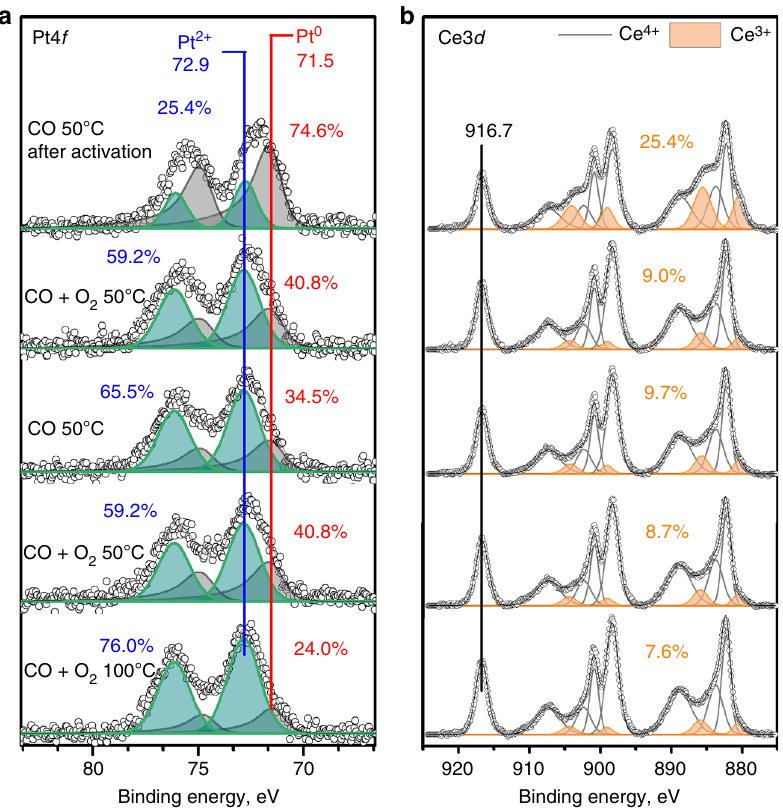
Fig. 6 NAP-XPS results for the 1wt.%Pt/CeO 2 TAPN catalyst synthesized by SEA after activation in CO at 275 °C: a Pt4 f region, b Ce3 d region. The catalyst was sequentially exposed to different gas environments, starting at the top. The Pt/Ce ratio remained at ~0.015 throughout the experiment